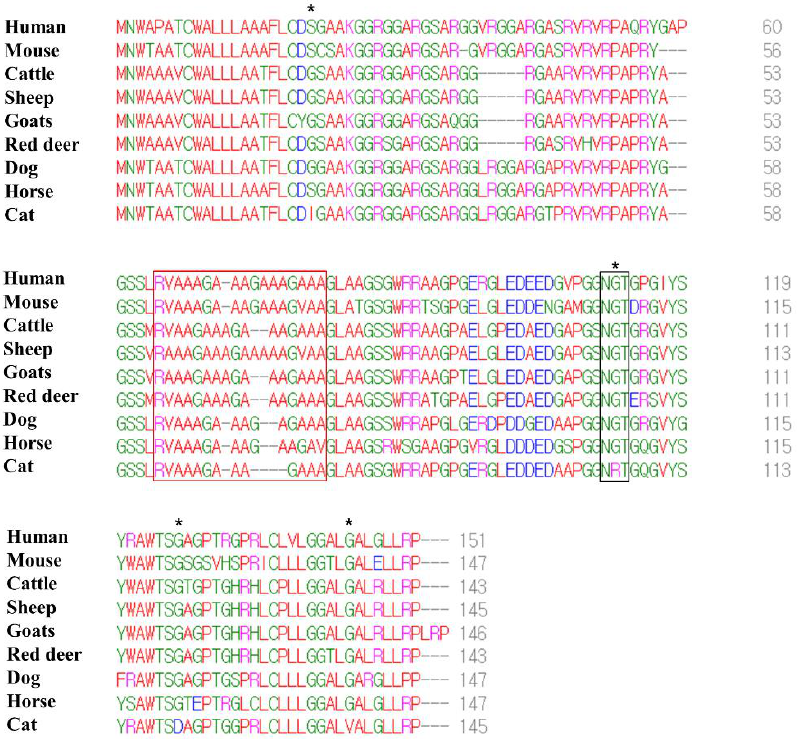
Figure 3. Multiple sequence alignments of the amino acid sequences in the shadow of prion protein (Sho) in humans, mice, cattle, sheep, goats, red deer, dogs, horses and cats. Colors indicate the chemical properties of the amino acids; blue: acidic; red: small and hydrophobic; magenta: basic; green: hydroxyl, sulfhydryl, amine and glycine. Asterisks indicate cat-specific residues. The red box indicates the interaction region of the Sho protein with prion protein (PrP). The black box indicates the NXT glycosylation motif of the Sho protein.